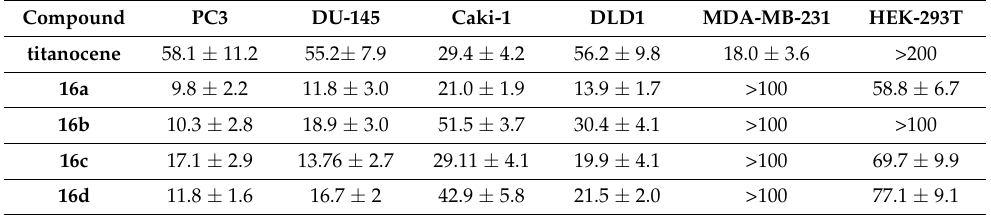
Figure 23. Chemical structure of bimetallic titanocene-gold-NHC complexes. Table 1. IC 50 values ( μ M) in human cell lines.